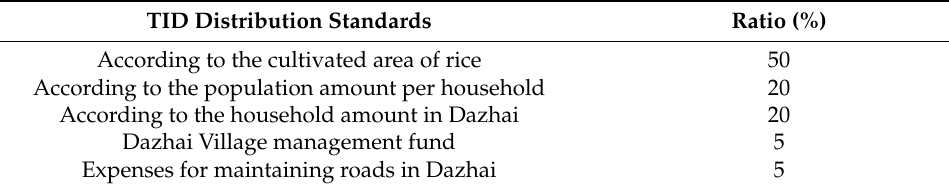
Table 3. The distribution scheme of